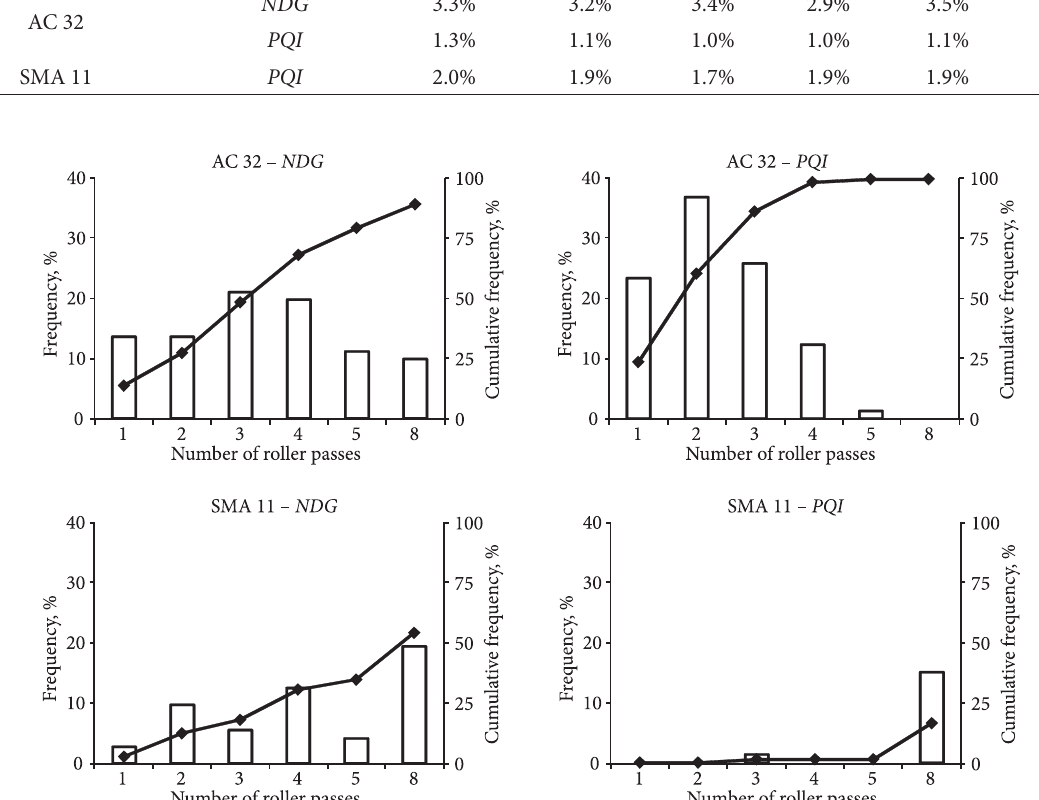
table 5. Average standard deviation (σ) of CD measurements in each test section measuring part Layer